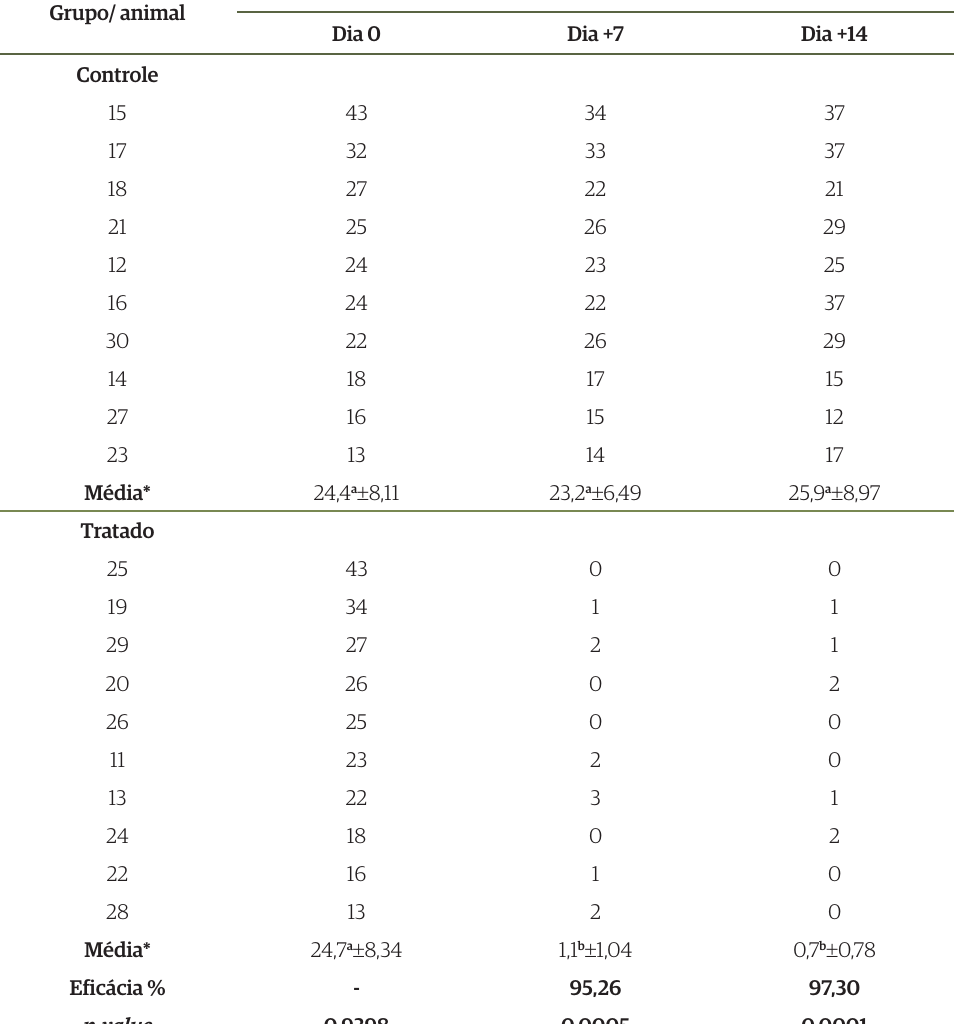
Tabela 1. Contagens individuais de larvas de Dermatobia hominis vivas dentro de nódulos nos bovinos do